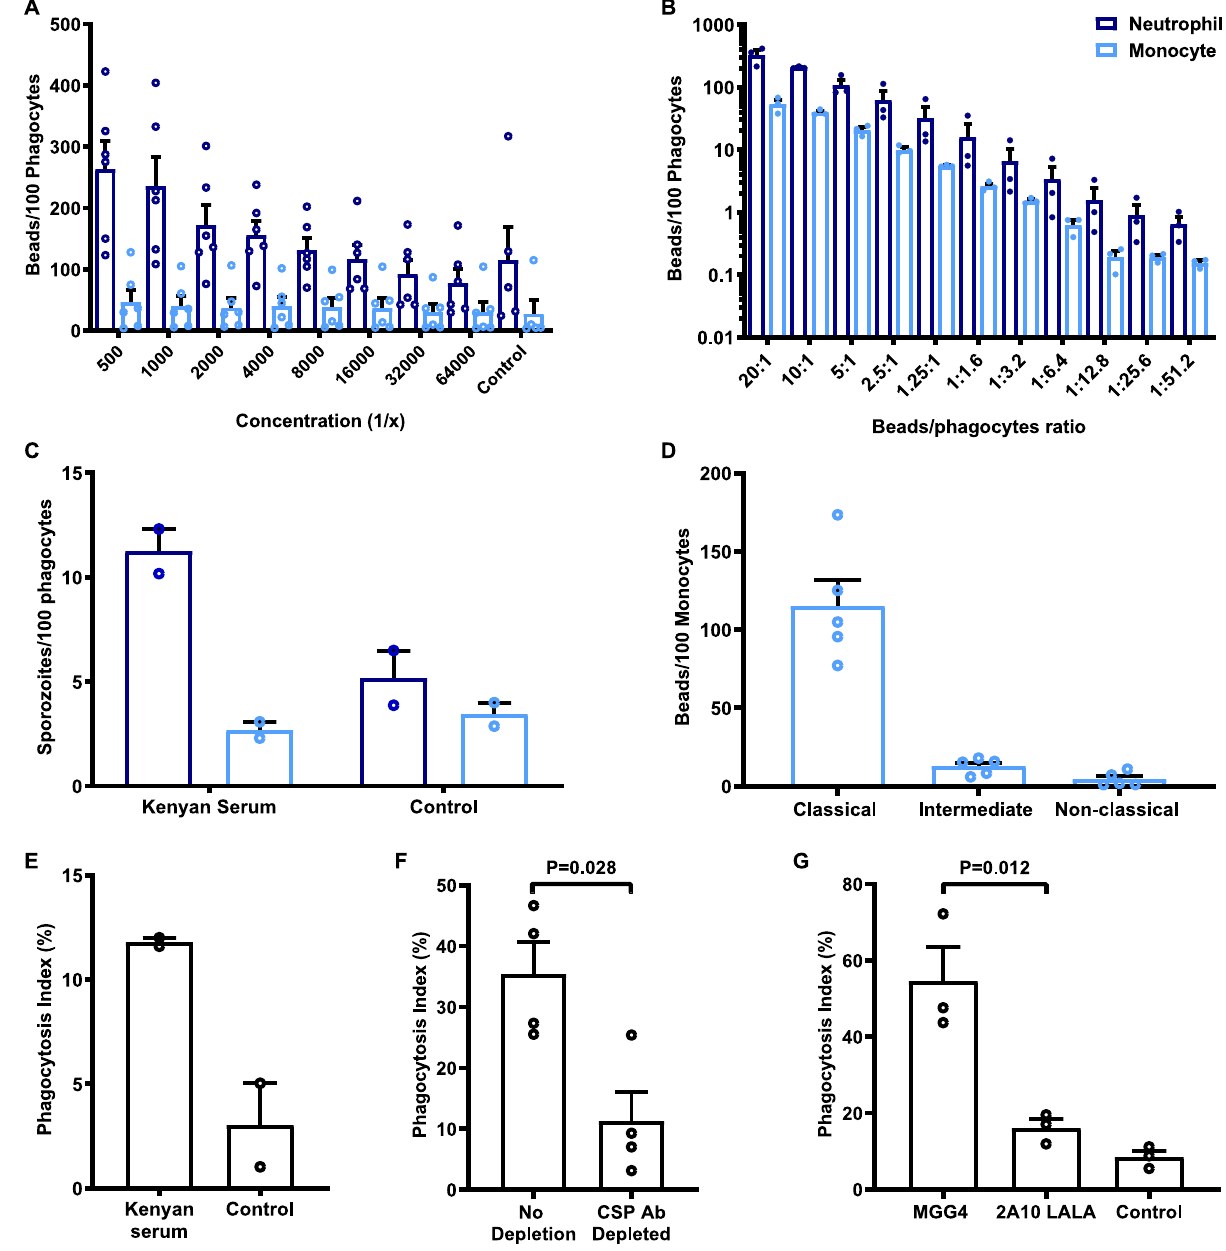
Fig. 1 Neutrophils predominately mediate opsonic phagocytosis of CSP-coated beads and sporozoites in whole blood. A CSP-coated beads were opsonized with different concentrations of rabbit anti-CSP IgG. Neutrophils showed greater phagocytosis activity compared to monocytes ( P < 0.001, two- way ANOVA). Bars represent the mean and standard error from six independent experiments. B CSP-coated beads opsonized with rabbit anti-CSP IgG (1/500 dilution), were co-incubated at different ratios with whole leukocytes. Phagocytosis activity was substantially higher by neutrophils than monocytes ( P < 0.001, two-way ANOVA). Bars represent the mean and standard error from three independent experiments. C Phagocytosis of sporozoites was tested using a transgenic PfCSP- P. berghei sporozoite line, opsonized with pooled immune sera from Kenyan adults. In the presence of immune antibodies, more sporozoites were phagocytosed by neutrophils (dark-blue bar) than monocytes (light-blue bar). Bars represent the mean and range from two independent experiments. D The number of beads phagocytosed by each monocyte subset was quanti fi ed and standardised as beads per 100 monocytes. The classical monocyte subset showed greater phagocytic activity ( P < 0.001, one-way ANOVA). Bars represent the mean and standard error from fi ve experiments. E Opsonization of P. falciparum sporozoites with a pool of malaria-exposed Kenyan adult sera induced a higher level of phagocytosis by neutrophils compared to unopsonized control. Opsonic phagocytosis activity was expressed as the percentage of ethidium bromide-positive cells. Bars represent the mean and range from two experiments. F Effect of depleting CSP-speci fi c antibodies from a pool of malaria-exposed Kenyan adult sera on opsonic phagocytosis of P. falciparum sporozoites by neutrophils. Depletion of CSP-speci fi c antibodies reduced opsonic phagocytosis by 70% (Man – Whitney test, P = 0.028). Bars represent the mean and standard error from four experiments. G mAb MGG4 (IgG1) was isolated from an individual exposed to P. falciparum sporozoites and was tested for promoting opsonic phagocytosis by neutrophils. Opsonic phagocytosis was signi fi cantly higher compared to a control mAb (2A10), which binds to the same epitope, but was modi fi ed (LALA mutations in the Fc region) to reduce Fc γ R binding (Mann – Whitney test P = 0.012). Bars represent the mean and standard error from three experiments. NATURE COMMUNICATIONS| (2021) 12:1742 |https://doi.org/10.1038/s41467-021-21998-4|www.nature.com/naturecommunications